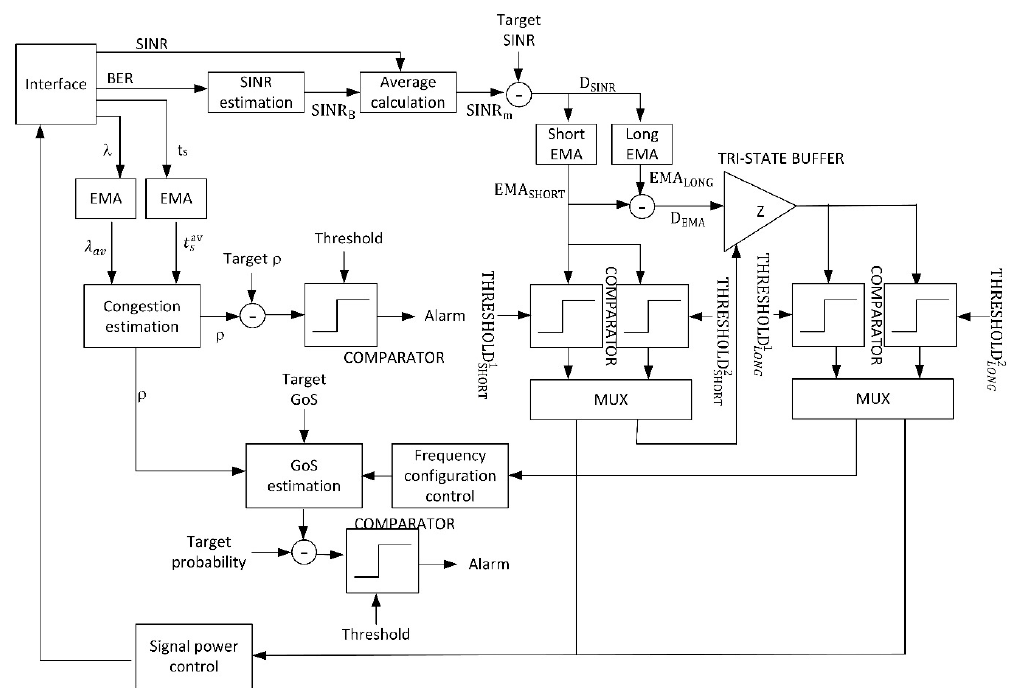
Figure 4. Block diagram for the proposed CPS control loop.